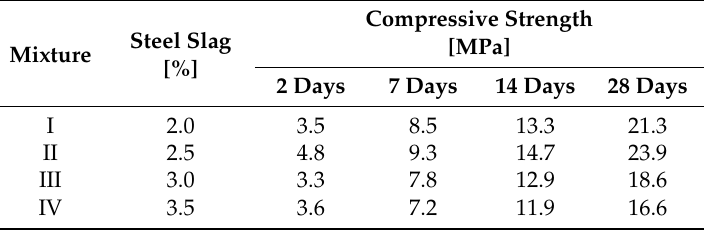
Table 4. Compressive strength at di ff erent ages and di ff erent percentages of steel slag addition [23]. Compressive Strength Steel Slag [MPa] Mixture [%]